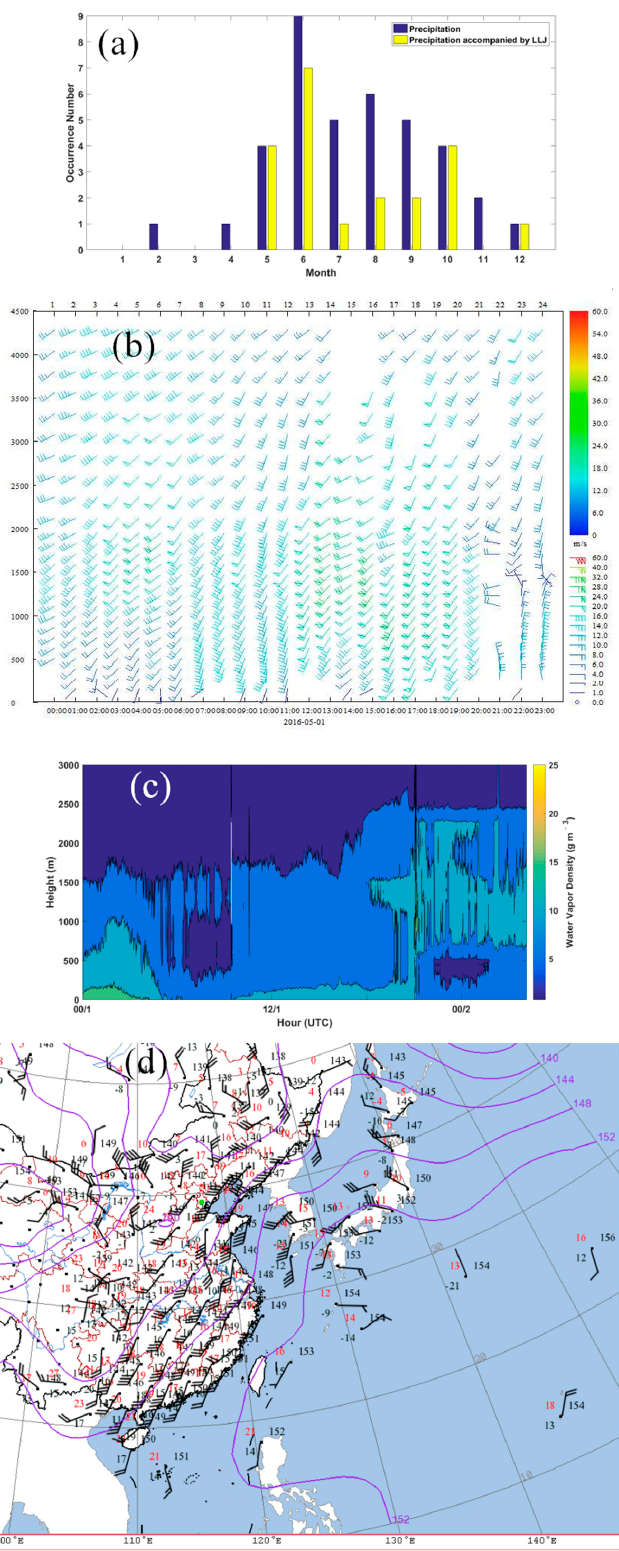
Figure 2. ( a ) Monthly occurrence numbers of all precipitation events and precipitation accompanied by Low-level jet (LLJ)in Tianjin in 2016. ( b ) Profile of wind speed obtained from wind-profile radar from 0000 UTC (LST = UTC + 8) to 2300 UTC 1 May. ( c ) Profile of water vapor density from 0000 UTC 1 May to 0400 UTC 2 May in 2016. ( d ) The contour chart and observations of meteorological parameters at 850 hPa at 2000 LST 1 May obtained from CMA (The green dot denotes the Meteorological Observation Station in Tianjin).